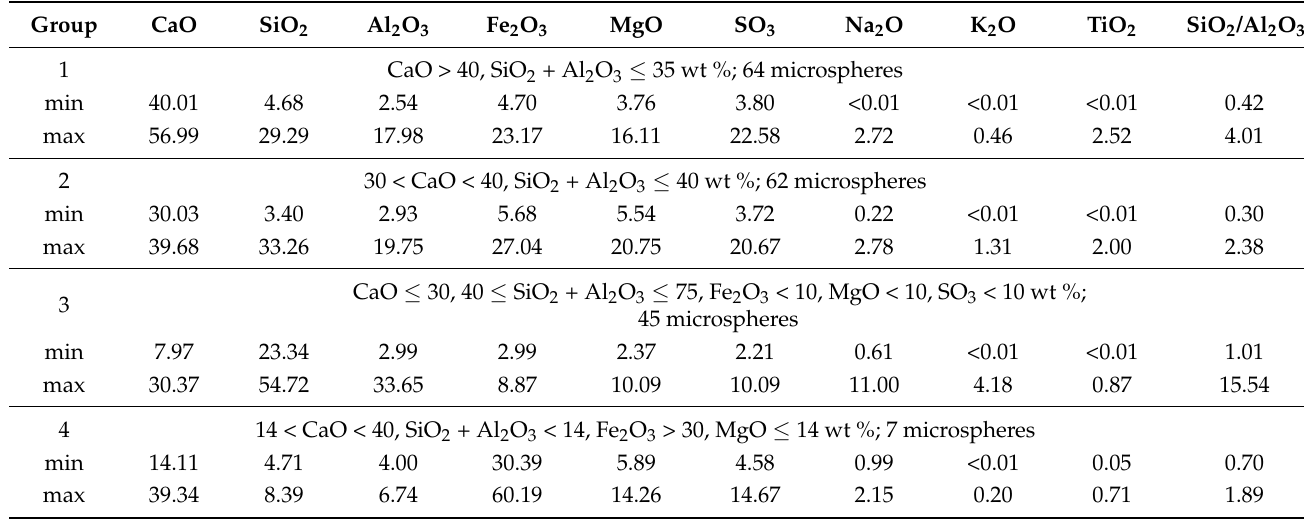
Table 2. The minimum and maximum values of oxide content (wt %) in PM 1-2